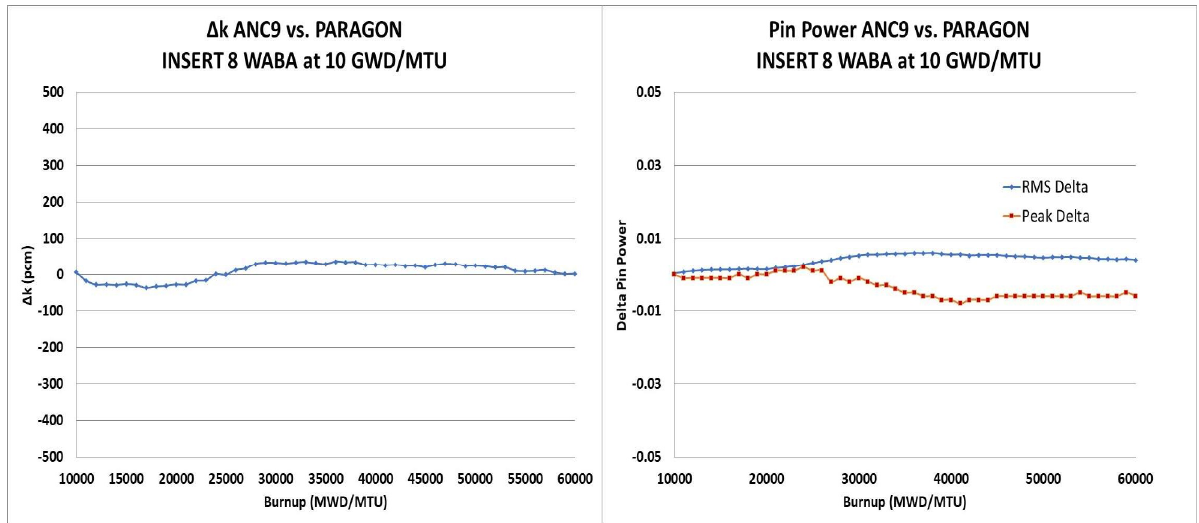
Figure 1. Comparison of eigenvalue and pin power for 8 WABA rods inserted at 10 GWD/MTU